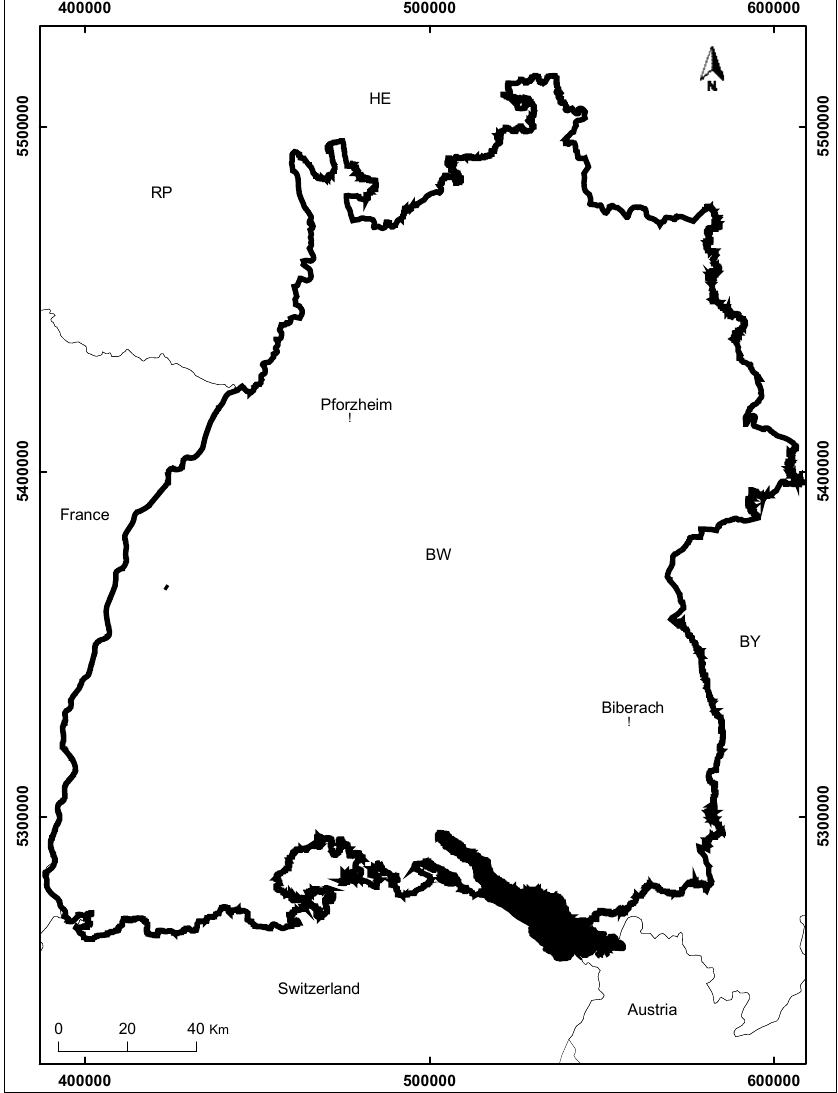
Figure 1. Location of study sites Pforzheim and Biberach in UTM coordinate system (zone 32N) with the surrounding countries and federal states (BW = Baden-Württemberg, BY = Bavaria, HE = Hesse, RP =